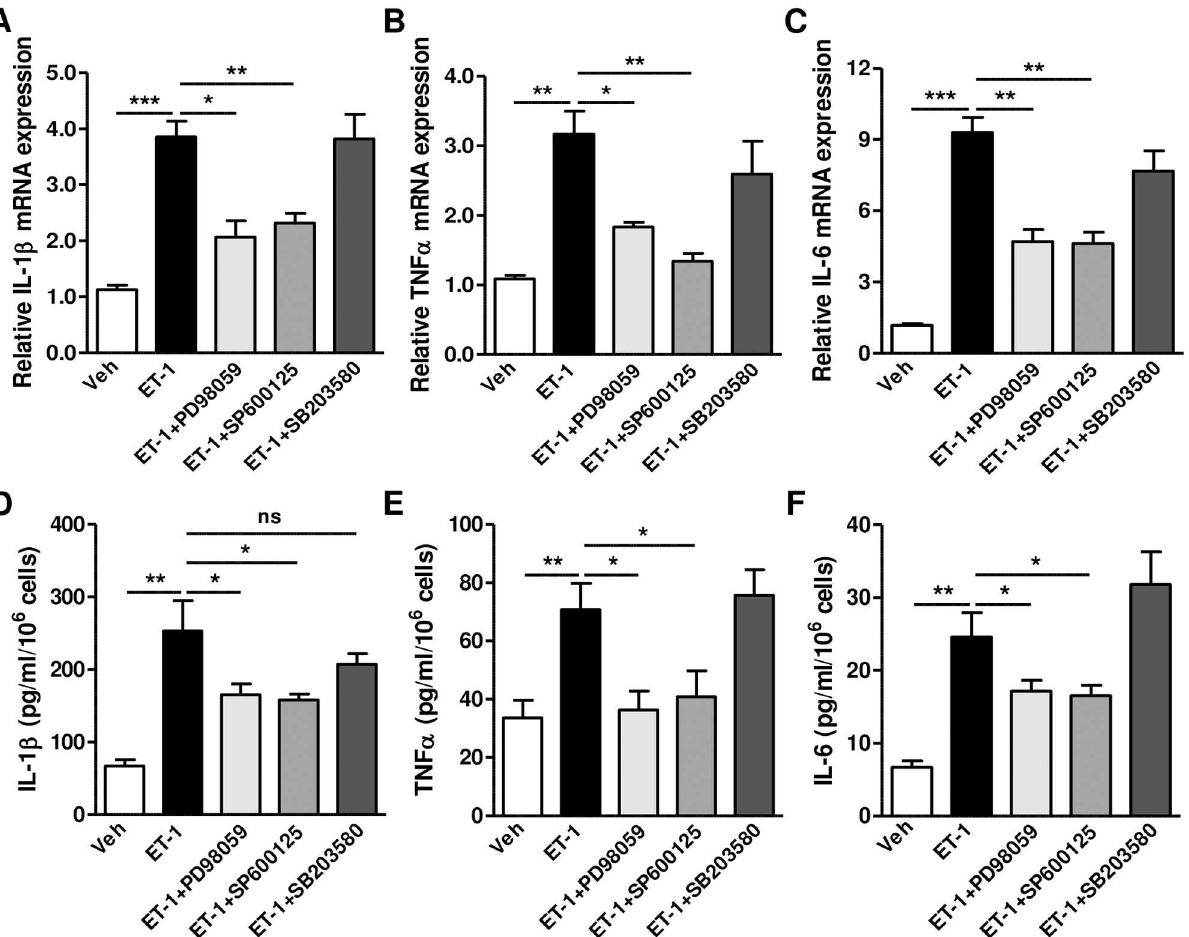
Fig 4. Involvement of MAPK in endothelin-mediated inflammatory cytokine production. (A to C) Effect of MAPK inhibitorson the ET- 1-mediated mRNA expressionof inflammatory cytokines. After pre-treatment with PD98059(10 μ M), SP600125(10 μ M), and SB203580 (10 μ M) for 20 min, HGECs were treated with ET-1 (100 nM) for 24h and mRNA expressionof IL-1 β (F), TNF α (G), and IL-6 (H) was measuredby quantitative RT-PCR. * P < 0.05; ** P < 0.01; ** P < 0.001. (D to F) Effect of MAPK inhibitorson the ET-1-mediated production of inflammatory cytokines. After pre-treatment with PD98059(10 μ M), SP600125(10 μ M) and SB203580(10 μ M) for 20 min, HGECs were treated with ET-1 (100 nM) for 24h and production of IL-1 β (F), TNF α (G), and IL-6 (H) was measuredby ELISA in culture supernatantsfrom five samples (sample#1–5). * P < 0.05; ** P < 0.01;ns: